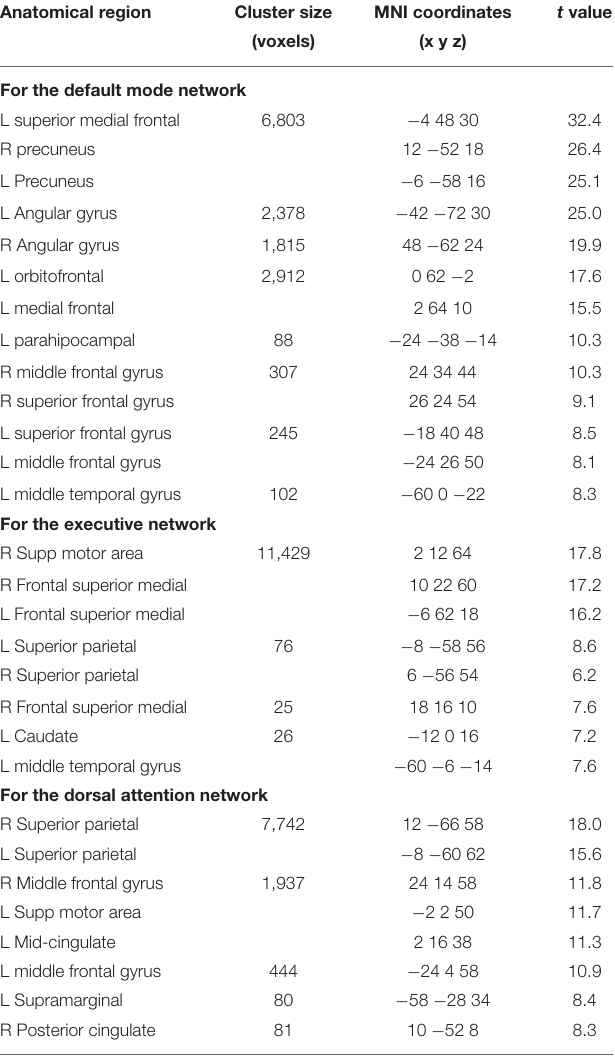
TABLE 2 | Resting-state network functional connectivity for controls and patients ( p < 0.05 FWE-corrected at whole brain level, cluster extent > 20 voxels). Anatomical